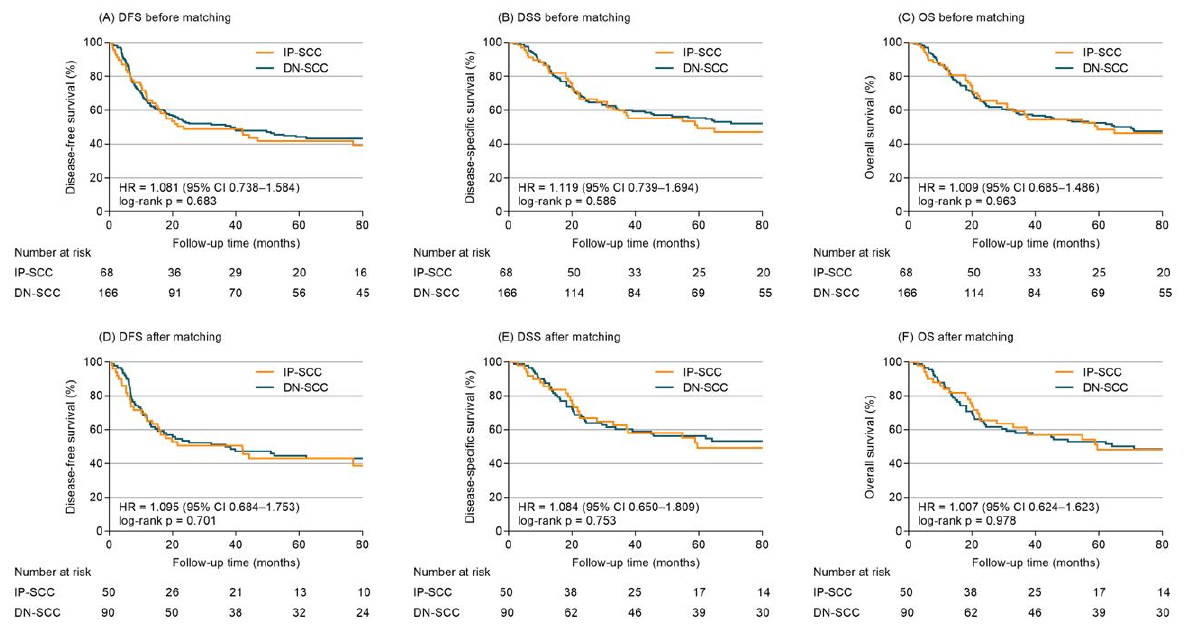
Figure 2. Survival outcomes of IP-SCC vs. DN-SCC for entire cohort before and after